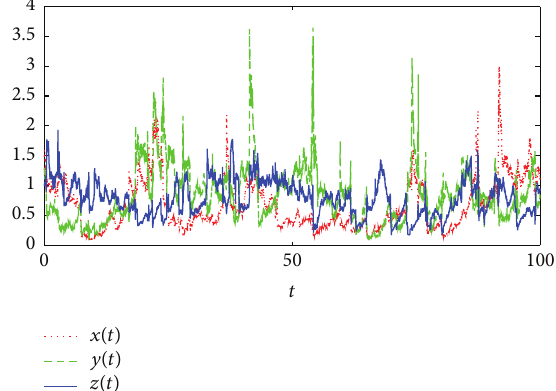
0.25𝑧 3𝑥) d 𝑡 1 + (𝑡) , 2